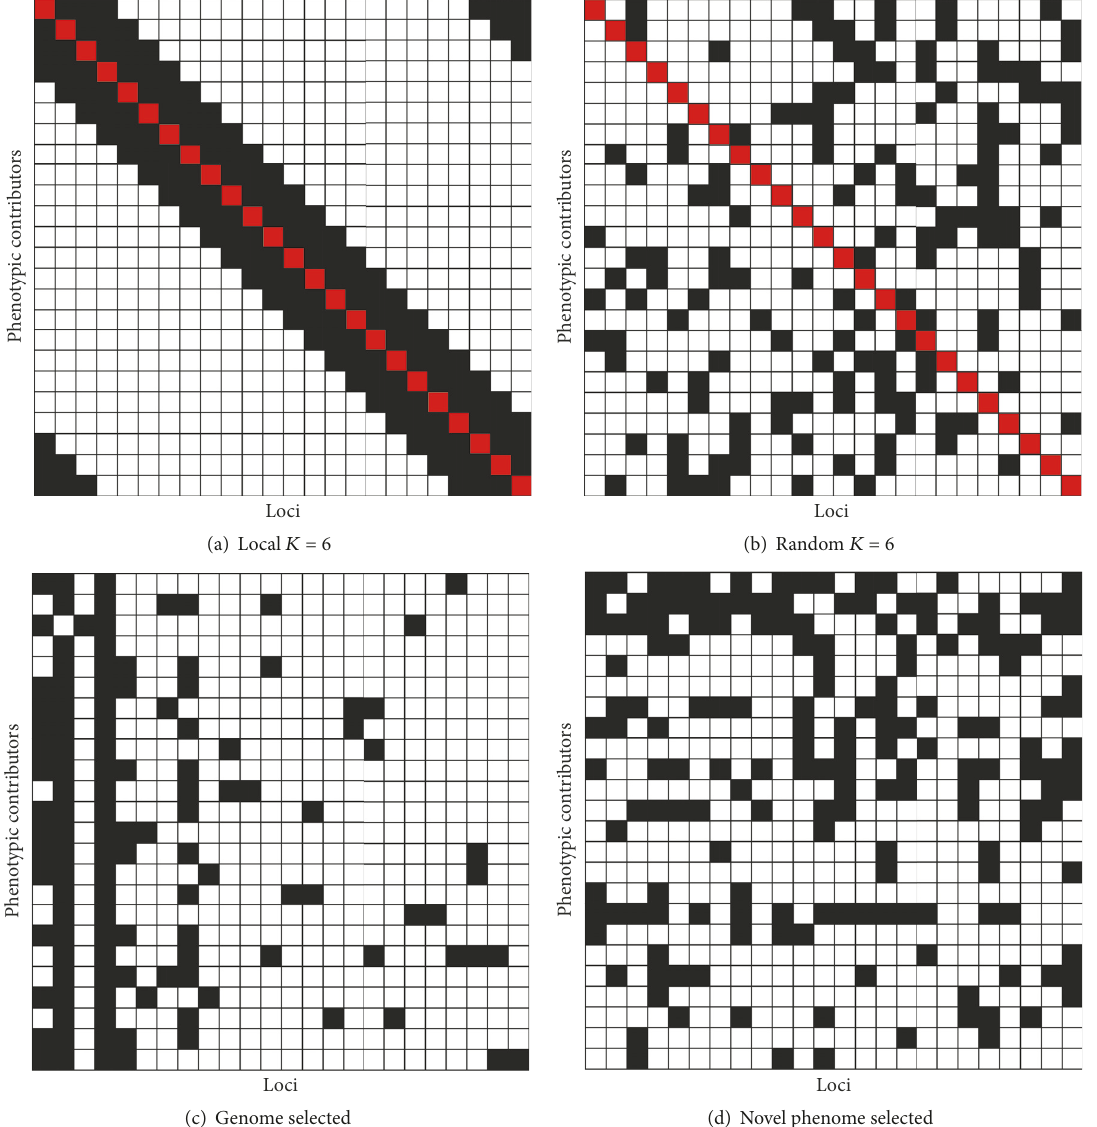
Figure 2: Comparison of interaction maps: in the interaction maps each row represents a phenotypic contributor with interacting loci coloured blue. The columns of each interaction map represent pleiotropy vectors while the rows represent epistasis vectors. In this context pleiotropy is a single base (dark squares) affecting multiple phenotypic contributors (rows), and epistasis is multiple bases (dark squares) affecting a single phenotypic contributor (row). (a) Kauffman’s local interaction map [35] in which both the epistatic and pleotropic vectors are equal to the 𝐾 value of 5. (b) Kauffman’s random interaction map [35] in which the epistatic vectors are equal to the 𝐾 value of 5 and the pleiotropic vectors are a Poisson distribution with a mean of the 𝐾 value of 5. (c) Altenberg’s genome selected interaction map [34] which is highly pleiotropic at a few loci (Fisher-Pearson coefficient of 1.76) as indicated by the vertically connected dark squares. Epistatic vectors are relatively equal (Fisher-Pearson coefficient of 0.13). (d) Our novel phenome selected interaction map, presented in the current study, in which both pleotropic and epistatic vectors are relatively equal (Fisher-Pearson coefficient of 0.07 and 0.69,